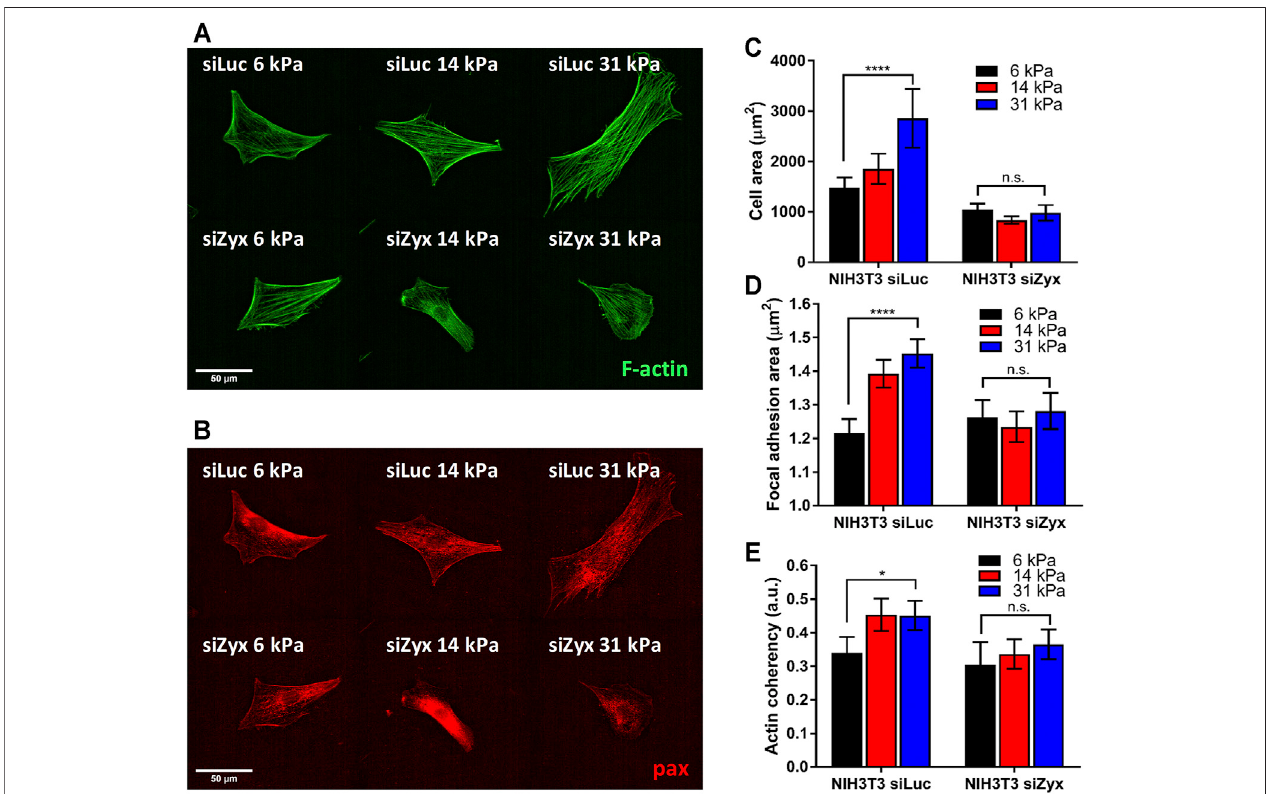
FIGURE 2 | Zyxin-knockdown NIH3T3 cells do not show increased cell-substrate adhesion and actin polarization in response to increasing substrate rigidity (A) RepresentativeF-actin(green)and (B) paxillin(red)immuno fl uorescencestainingimagesforsiLuc-andsiZxy-NIH3T3cellsatdifferentsubstraterigidity (C) Graphofcellarea vs substrate rigidity for siLuc- and siZyx- NIH3T3 cells (D) Graph of focal adhesion (FA) area vs substrate rigidity for siLuc- and siZyx- NIH3T3 cells (E) Graph of F-actin coherencyvssubstrate rigidityfor siLuc- and siZyx-NIH3T3cells.n (cid:2) 12, 16, 19for siLuc NIH3T36 kPa,14and 31 kPa respectively. n (cid:2) 10, 15, 11for siZyx NIH3T3 6 kPa, 14 and 31 kPa respectively. Error bars represent standard error of the mean. **** represents p < 0.001, * represents p < 0.05 and n.s represents not signi fi cant.